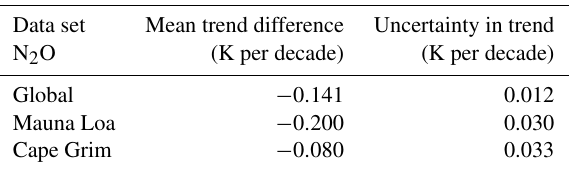
Figure 12. Retrieved N 2 O anomalies compared to ESRL global in situ data. The N 2 O anomaly difference between AIRS and ESRL is shown in yellow. The magenta curve is that difference converted into BT units. Table 5. Slope of the (AIRS – ESRL) N 2 O anomalies in K per decade